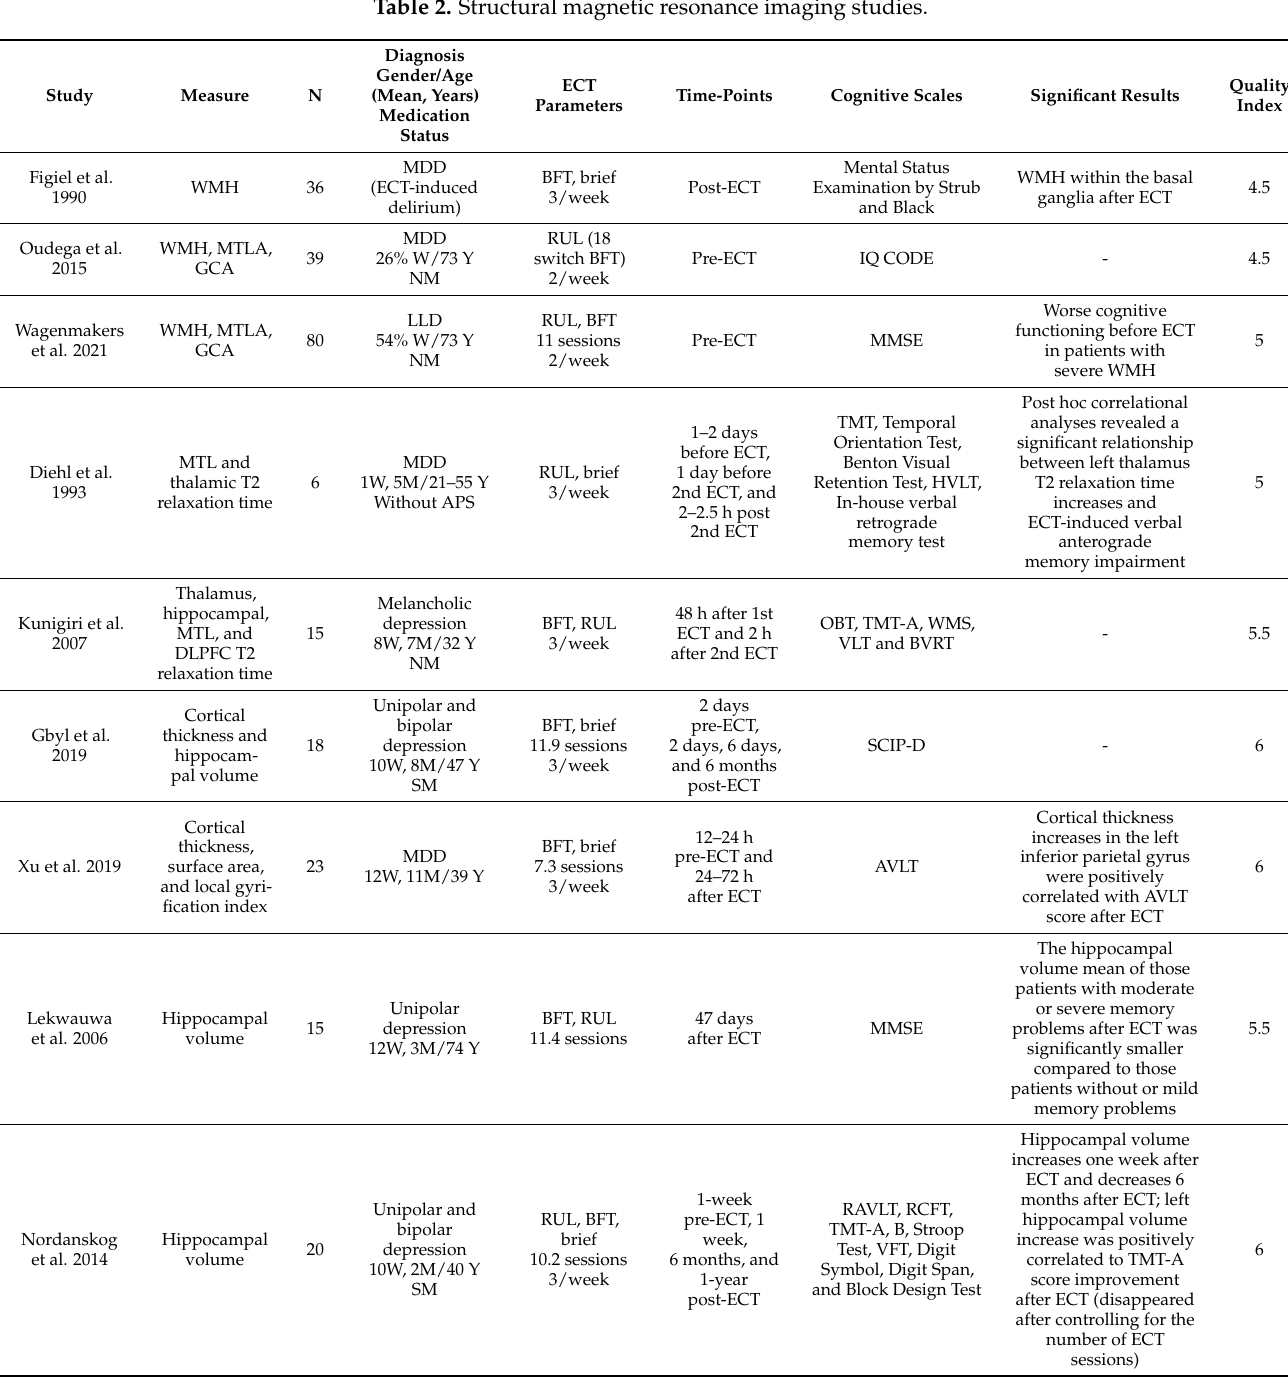
Table 2. Structural magnetic resonance imaging